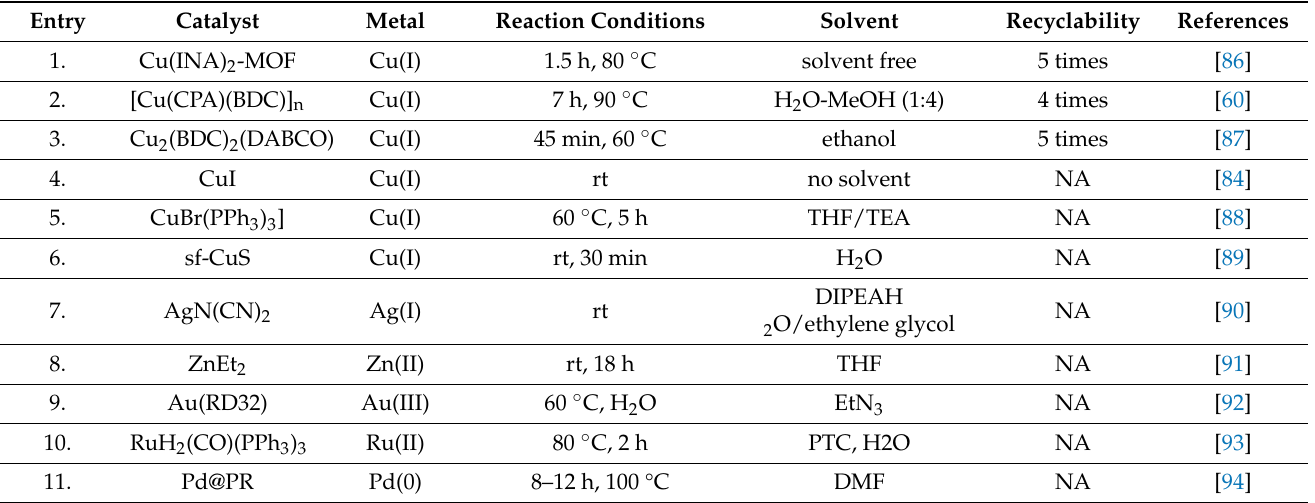
Table 4. Comparison of Cu-based MOF over other catalysts used to catalyze an alkyne azide cycloaddition